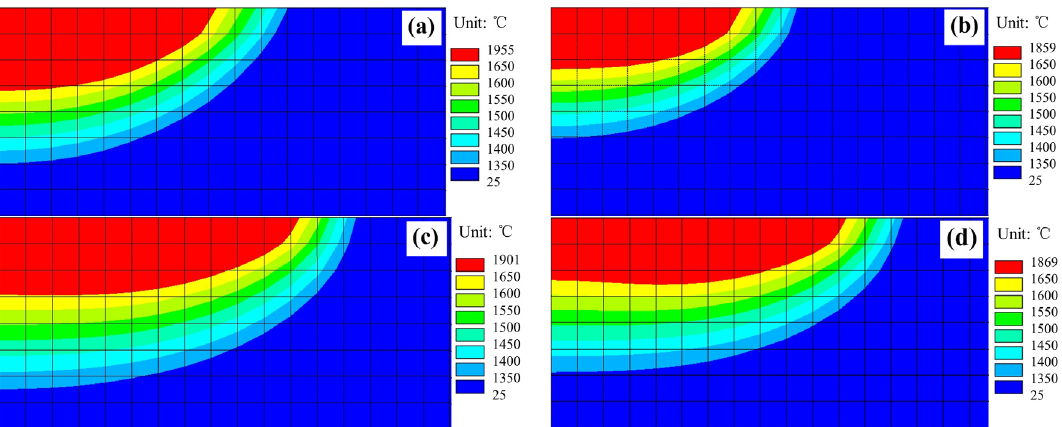
Figure 9. Temperature distributions in cross sections of substrates under the four laser deposition conditions (dimensions of cross-section shown: 1.7 mm × 0.8 mm). ( a ) CN; ( b ) CF; ( c ) SN; ( d ) SF.